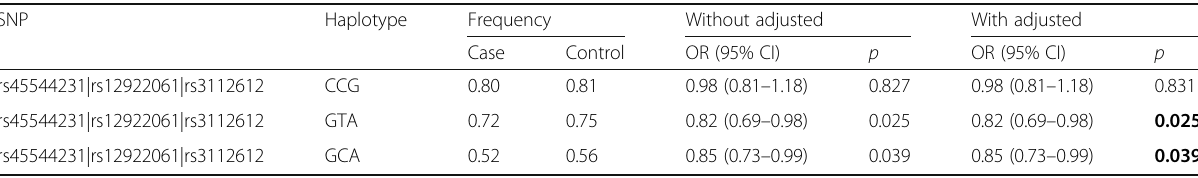
p value calculated by Wald test with and without adjusted by age Highlighted in bold indicates the significant association between SNPs and breast cancer